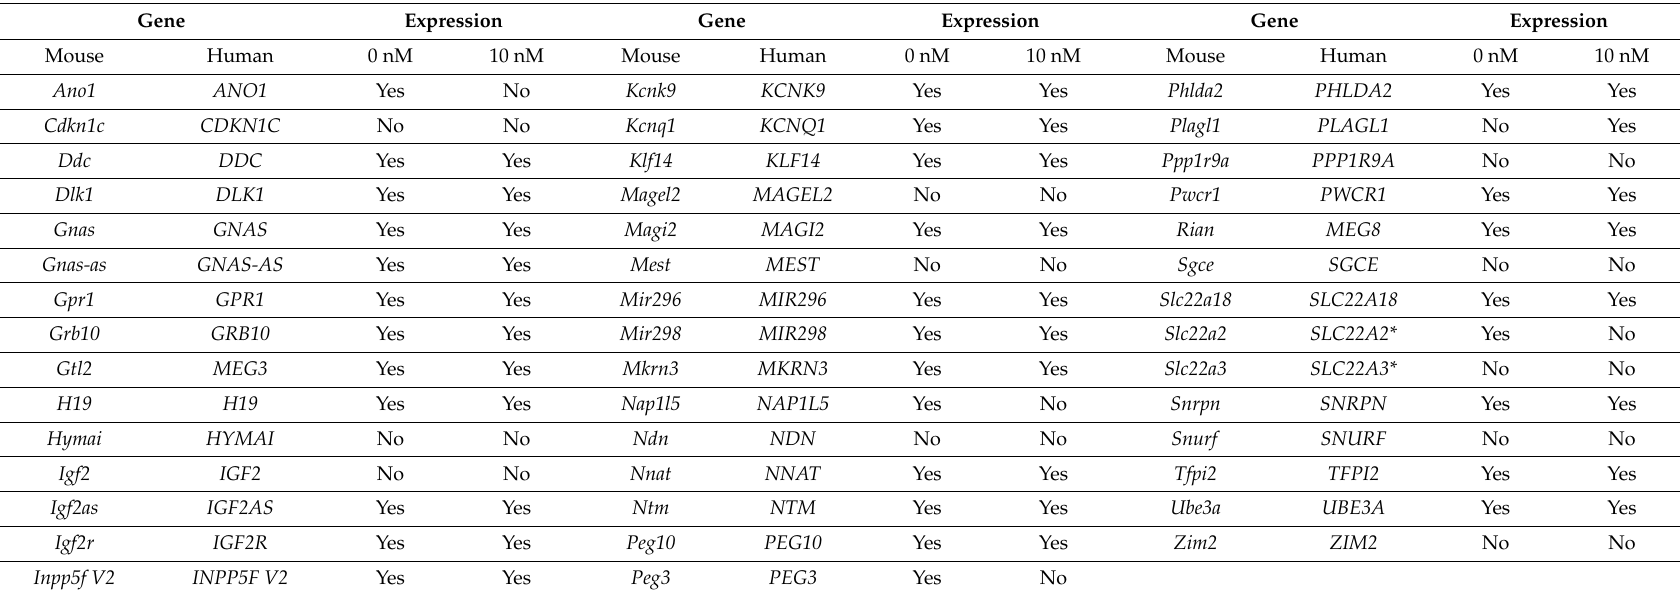
Table 1. List of the imprinted genes examined in TM-4 Sertoli